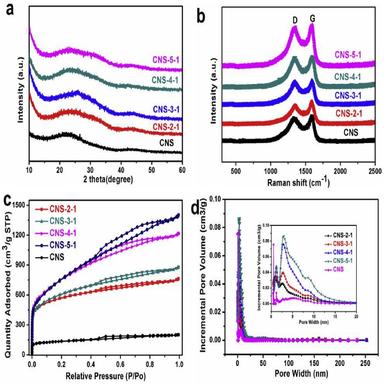
a) The X-Raw diffraction, b) Raman spectra, c) N2 de-adsorption isotherm and d) specific pore distribution curves of CNS and CNS-X 1 (X ¼ 2, 3, 4, 5). (A colour version of this figure can be viewed online.)